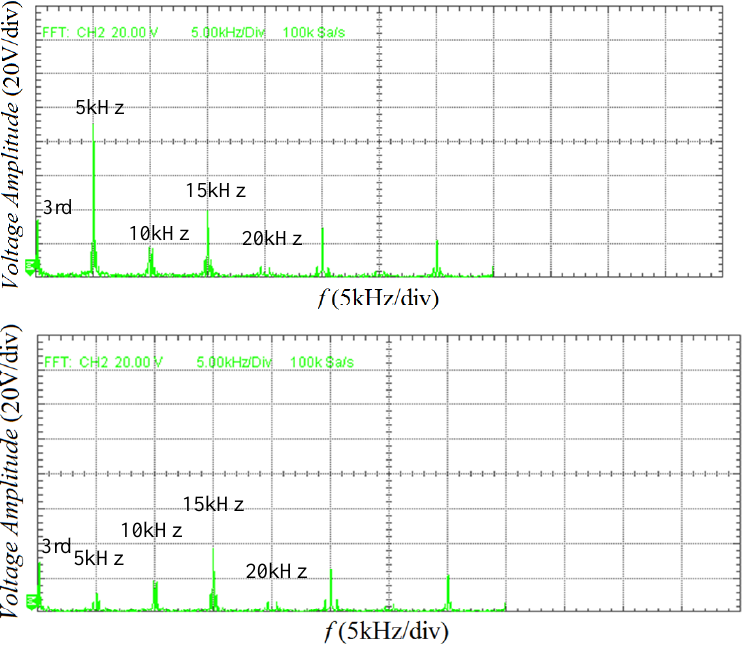
Figure 22. The spectral analysis of experimental sub-CMV results ( top ) DZIPWM; ( bottom ) DZICMV.